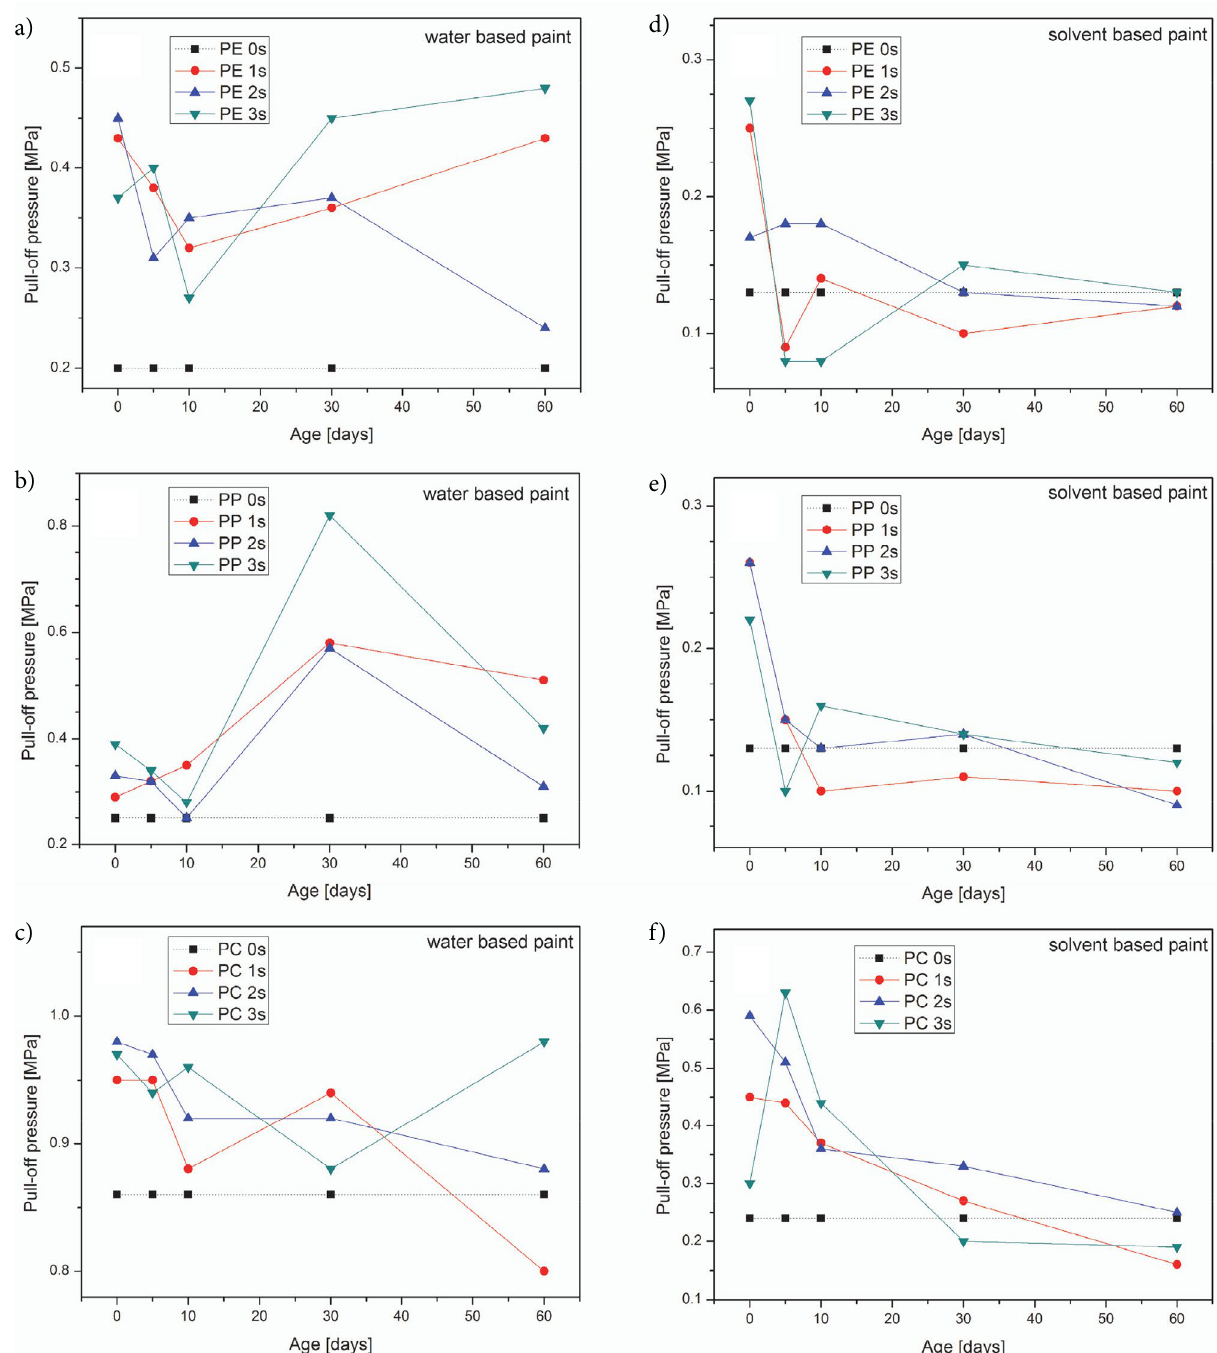
Figure 2. Pull-off test results for water and solvent based paint on the PE, PP and PC substrates. Untreated sample is always labeled “0